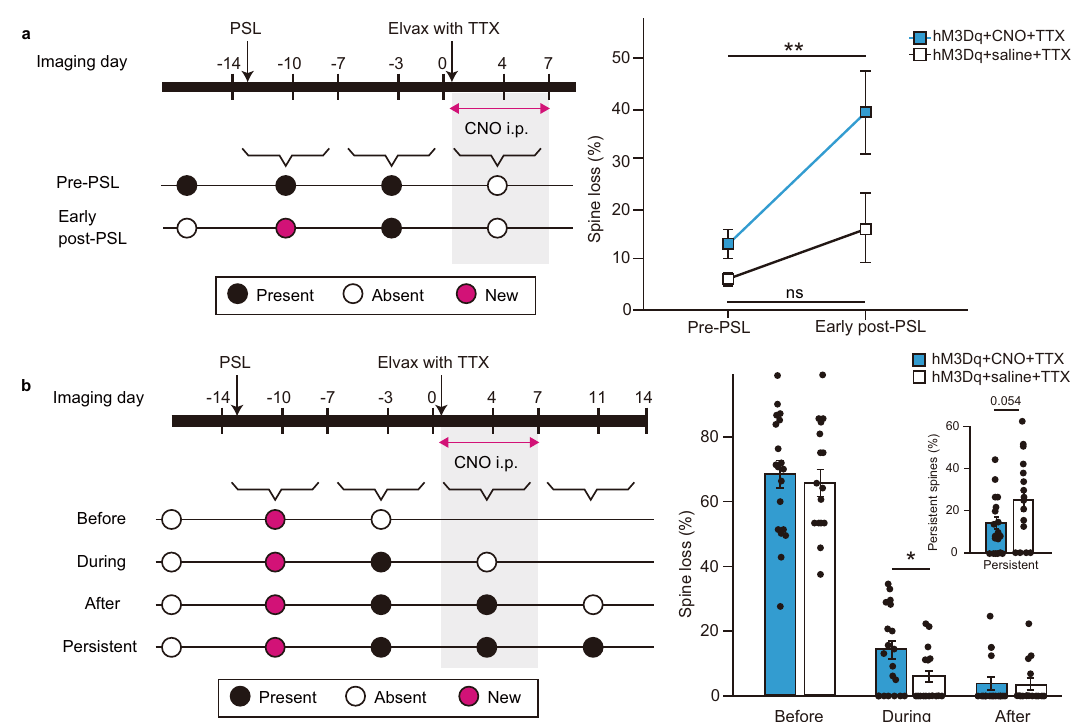
Fig. 4 CNO-TTX therapy enhances the preferential elimination of dendritic spines that are likely associated with maladaptive noxious circuits. a Left panel: Schematic categorizing spines eliminated during CNO-TTX (or control) treatment. “ Pre-PSL ” spines were present before PSL and before starting CNO-TTX treatment. “ Early post-PSL ” spines appeared in the week after PSL and were still present before starting CNO-TTX treatment. Right panel: Graph plotting the proportion of eliminated pre-PSL or early post-PSL spines during CNO-TTX (blue, 19 dendrites from 5 mice) or control saline-TTX (white, 16 dendrites from 7 mice) treatment as mean ± SEM. Statistical signi fi cance was tested using a two-way ANOVA, followed by Bonferroni post hoc tests comparing spine categories within each treatment cohort, ** p < 0.01. Source data are provided as a Source Data fi le. b Left panel: Schematic further categorizing early post-PSL spines based on whether they were eliminated “ Before ” , “ During ” or “ After ” CNO-TTX (or control) treatment or were “ Persistent ” (not eliminated). All of these spine categories are likely associated with maladaptive noxious circuits. Right panel: Graphs plotting the proportional representation of each category of early post-PSL spines for CNO-TTX ( n = 19 dendrites from 5 mice with 171 spines in total) and control saline-TTX ( n = 16 dendrites from 7 mice with 119 spines in total), as mean ± SEM with single points representing individual dendrites. Statistical signi fi cance was tested using an unpaired two-sided t test comparing treatment cohorts for each spine category, * p < 0.05. Source data are provided as a Source Data fi cohorts were signi fi cantly different (lidocaine with tDCS vs lidocaine without tDCS, a two-way repeated measures ANOVA: interaction effect: F(6, 48) = 2.5, p = 3.5E − 2; followed by Bon- ferroni post hoc analysis, Spontan. ( p = 0.50), day 0 ( p = 0.18), day 1( p = 0.68), day 3 ( p = 0.18), day 7 ( p = 4.4E − 2), day 14 ( p = 3.7E − 2), day 21( p = 4.1E − 2)). As we also observed with the CNO-TTX therapy experiments (Supplementary Fig. 13), com- bination tDCS-lidocaine therapy did not adversely affect motor coordination in the rotarod assay (Fig. 5c, lidocaine with tDCS (blue, n = 6), post-PSL time to fall: 84.8 ± 9.9 s, day 4: 102.8 ± 13 s, day8: 132.4 ± 13 s; lidocaine without tDCS, n = 5, post-PSL time to fall: 87.2 ± 4.1 s, day 4: 102.1 ± 11 s, day8: 119.0 ± 4.6 sec; lidocaine with tDCS vs lidocaine without tDCS, a two-way repeated measures ANOVA: interaction effect: F(2, 18) = 6.9, p = 0.74, the main effect: F(1, 9) = 0.22, p = 0.65), or locomotion and anxiety-like behaviours in the open- fi eld test (Fig. 5d, lidocaine with tDCS: (blue, n = 6), speed: 37 ± 1.0 mm/s, distance: 21.7 ± 1.0 m, inner zone: 20.4 ± 9.0 s; lidocaine without tDCS, (white, n = 5), speed: 3.9 ± 1.5 mm/s, distance: 24.4 ± 1.5 m, inner zone: 22.8 ± 3.8 s; lidocaine with tDCS vs lidocaine without tDCS unpaired two-sided t -test, speed (t(9) = − 1.6, p = 0.14), distance (t(9) = − 1.5, p = 0.16), dura- tion in inner zone (t(9) = − 0.22, p = 0.83)).